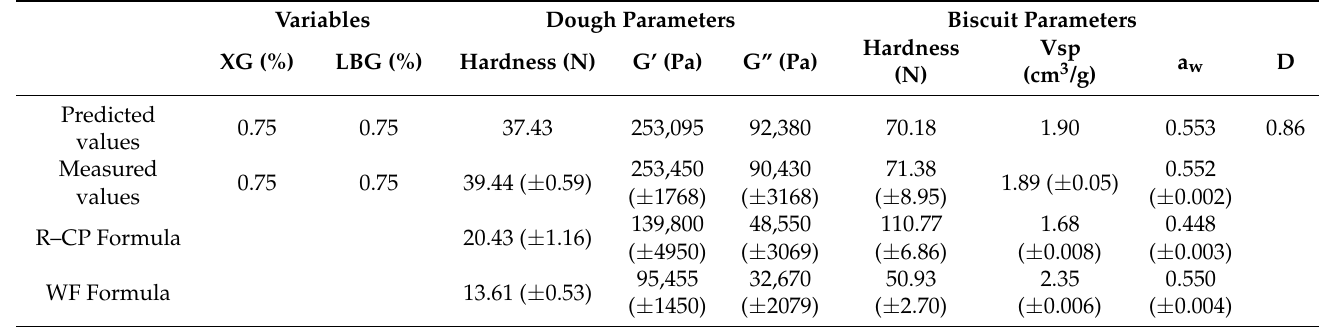
Table 5. Predicted and measured values of the rheological and physical parameters of the optimum selected formula compared to control (R-CPF and WF) formulas (% flour